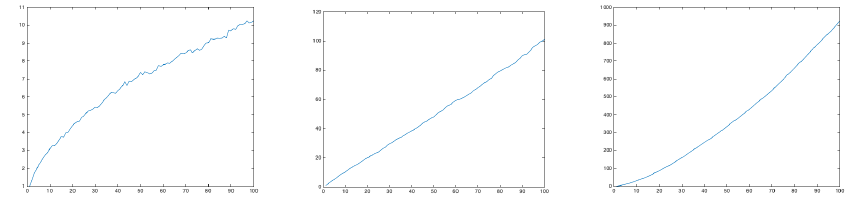
Figure 14. Mean square displacement evolution for the population of profiles generated by a fractional Brownian motion characterized by H = 0.25 ( left ), H = 0.5 ( center ) and H = 0.75 ( right